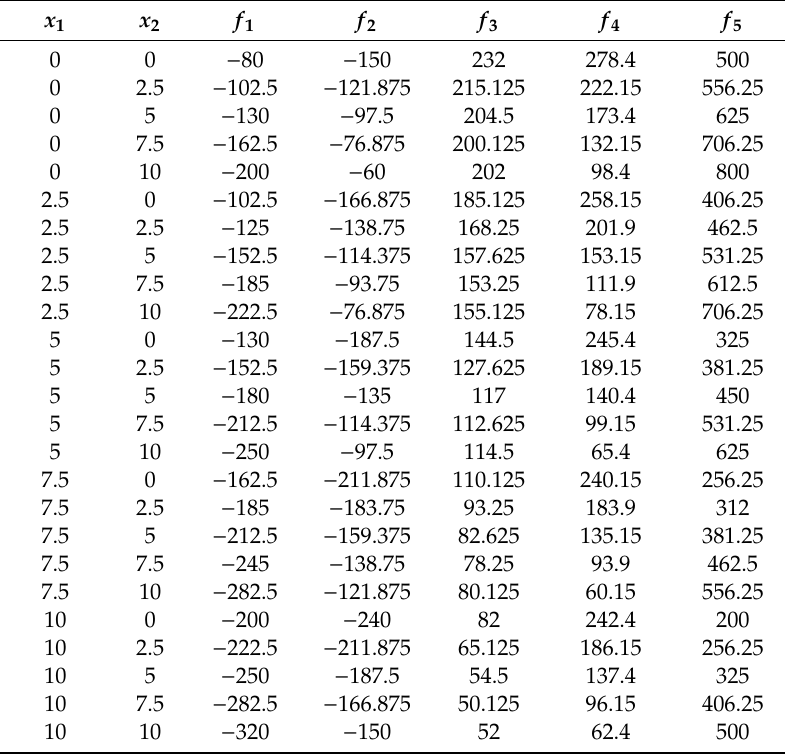
Table 5. Experimental data (matrix